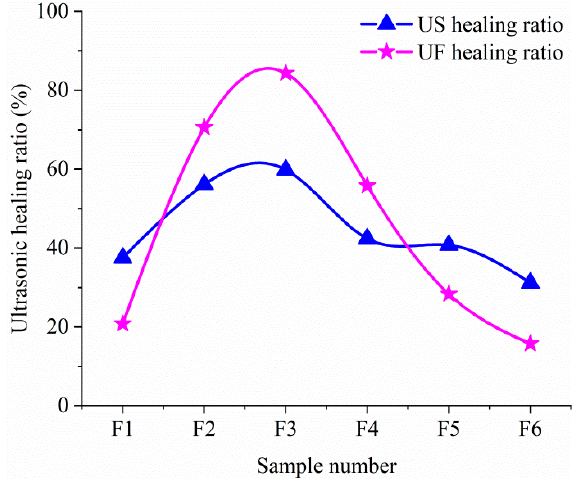
Figure 8. The US and UF healing rates of samples.